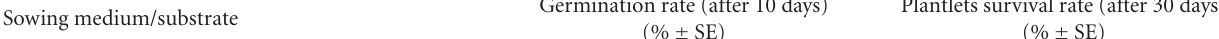
Table 2: E ff ect of di ff erent sowing media/substrates on germination rate of synthetic seeds of Oryza sativa L. Cv. MRQ 74. Sowing medium/substrate